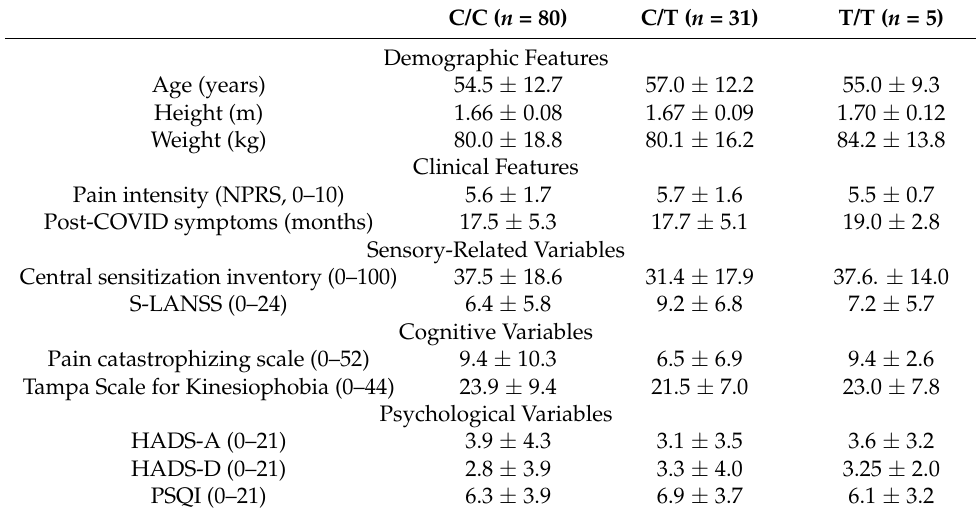
Table 5. Differences in clinical, sensory-related, cognitive and psychological variables in individu- als with post-COVID pain depending on the brain-derived neurotrophic factor ( BDNF ) Val66Met polymorphism ( rs6265 ).